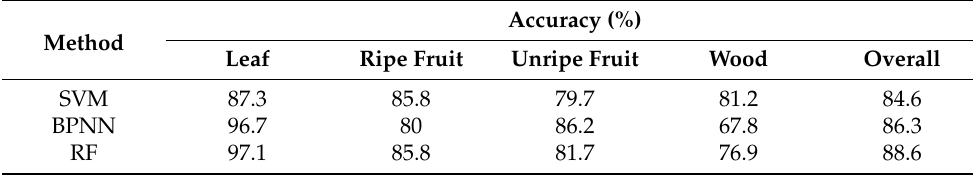
Table 2. Comparison of the three classifiers’ accuracy.